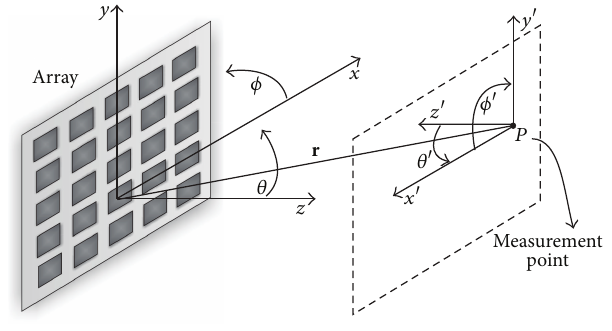
Figure 1: Problem geometry.